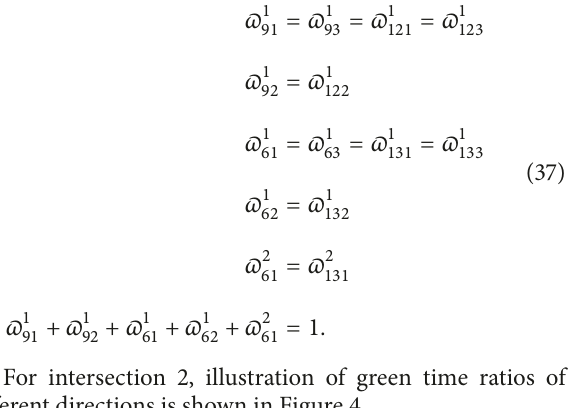
Figure 4: Illustration of green time ratios in intersection